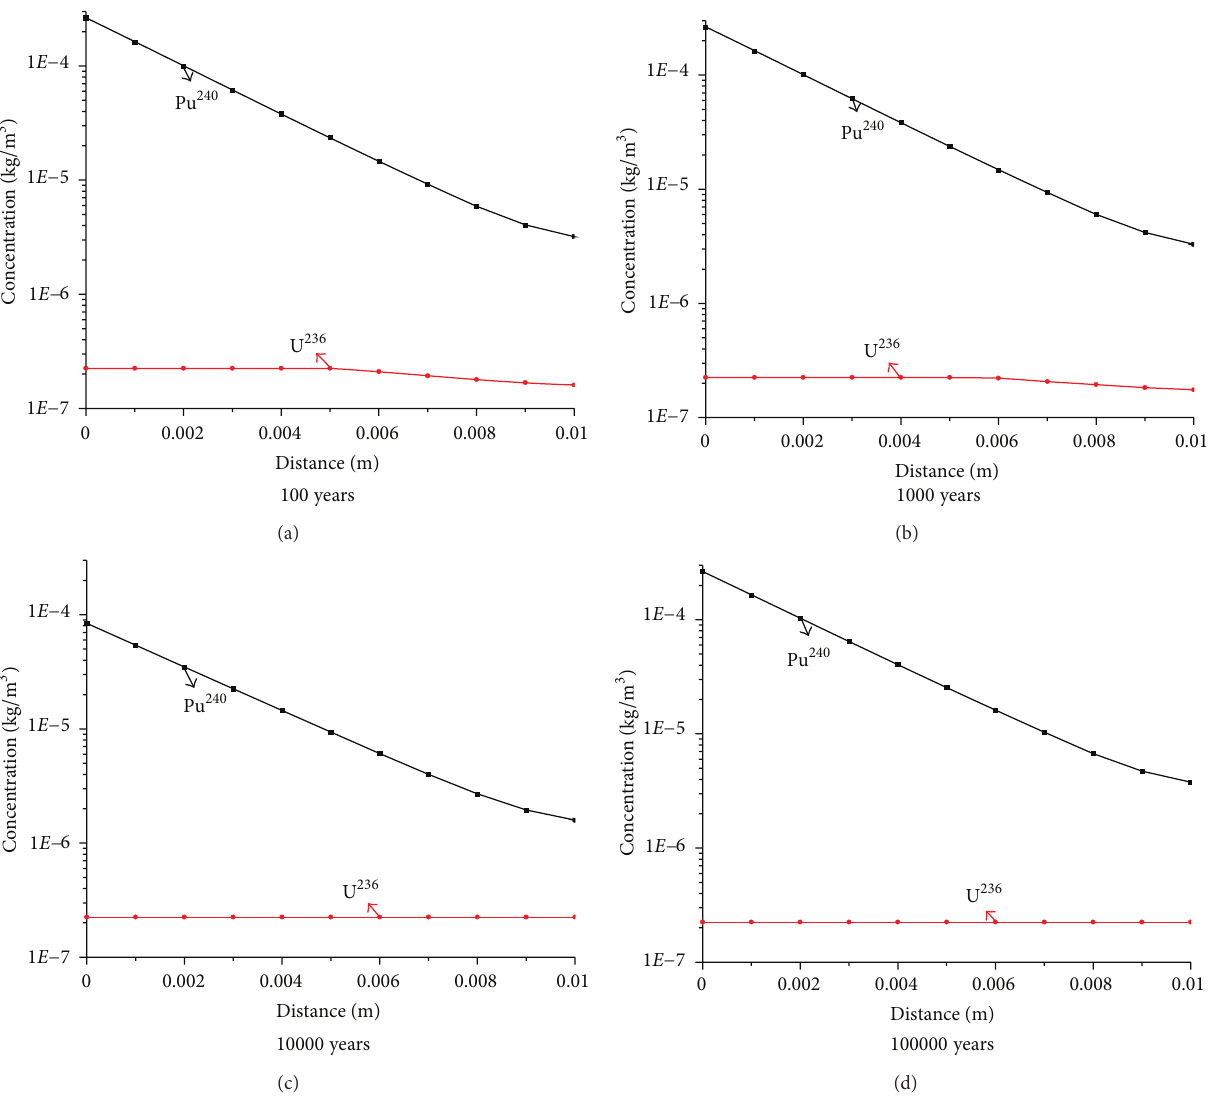
Figure 7: Concentration profiles in extruded bentonite region, for nuclides of 4 𝑛 chain (Pu 240 → U 236 ) for 10 2 , 10 3 , 10 4 , and 10 5 years.